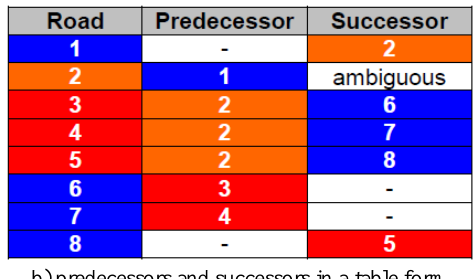
b) predecessors and successors in a table form Figure 3. Ambiguous situation with branching roads in a junction (ASAM e.V., 2022)